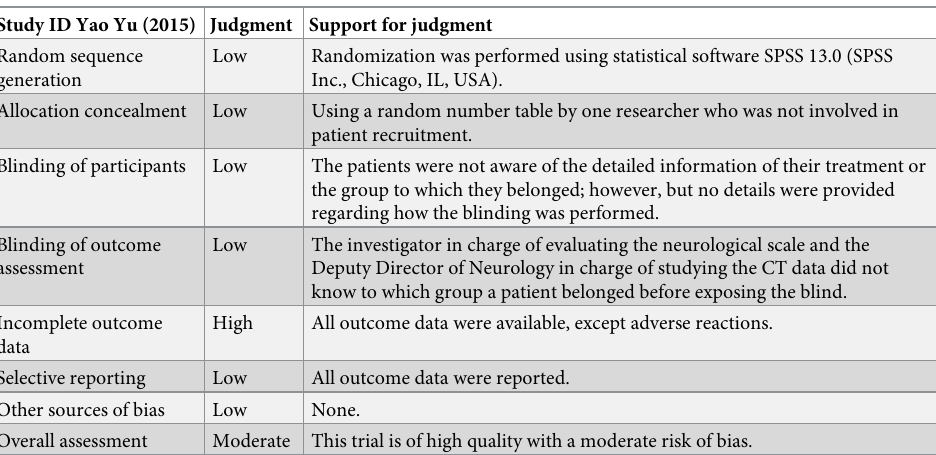
Table 4. Study quality for